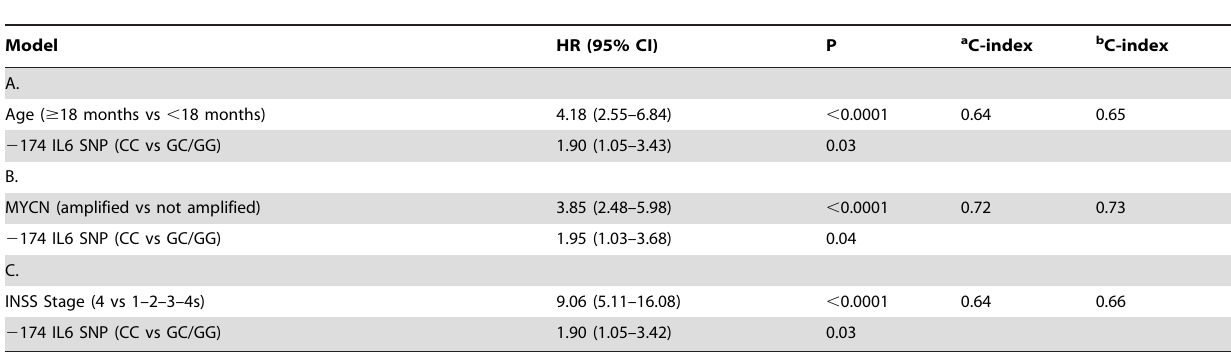
Table 3. Test for independent statistical significance of 2 174 IL-6 SNP after adjustment for NB risk factors.